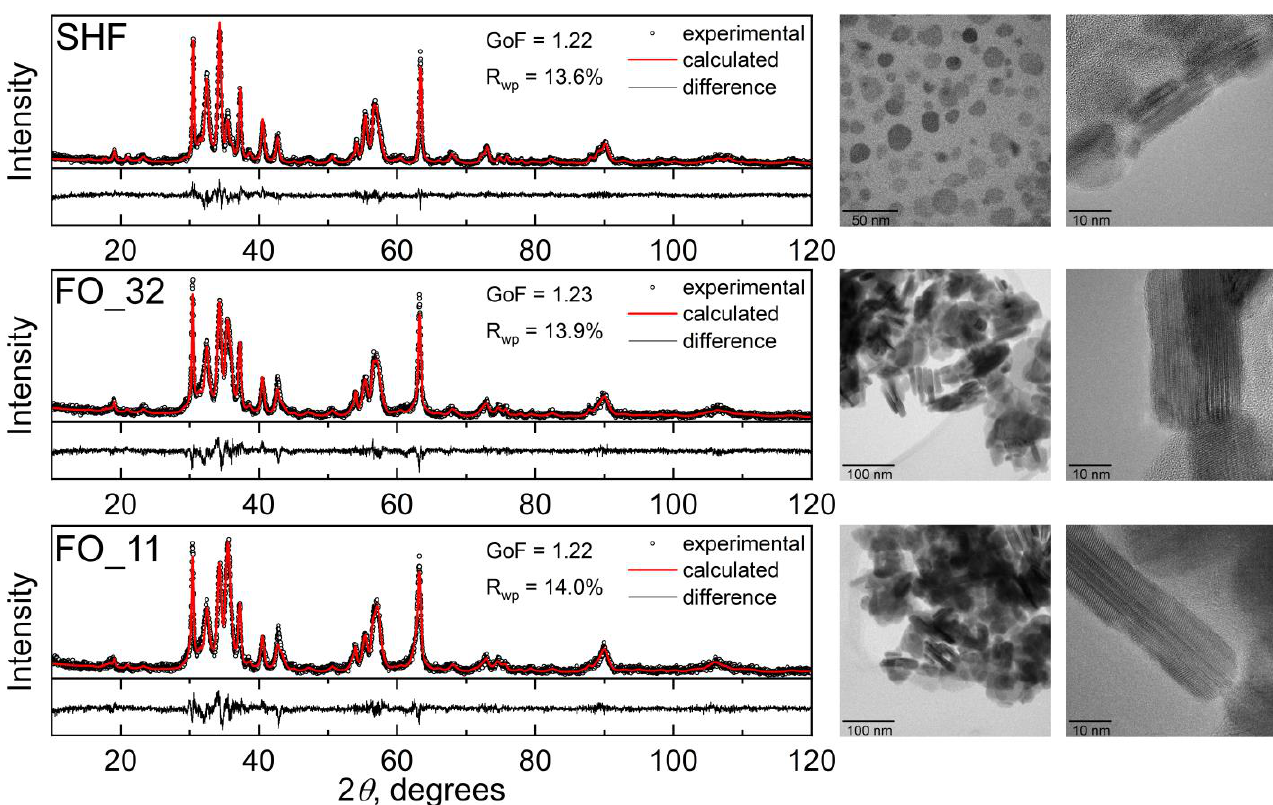
Figure 1. X-ray diffraction patterns ( left ) and transmission electron microscopy images ( right ) of the hexaferrite and composite samples.